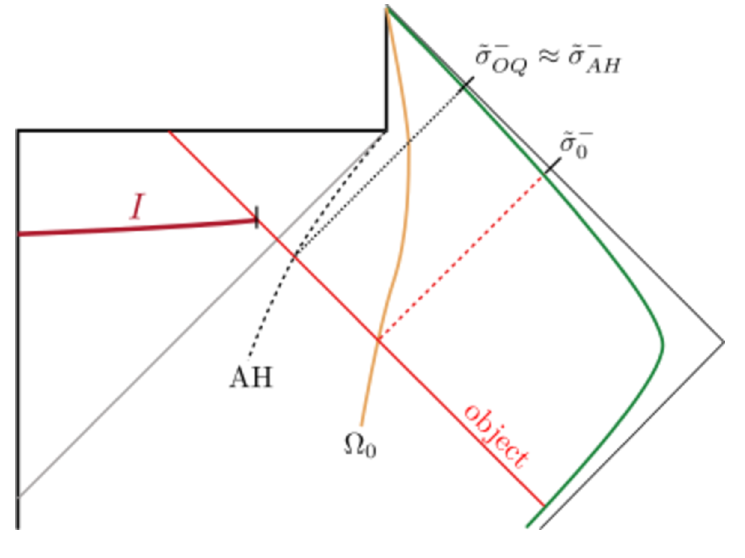
Figure 6 . Scrambling